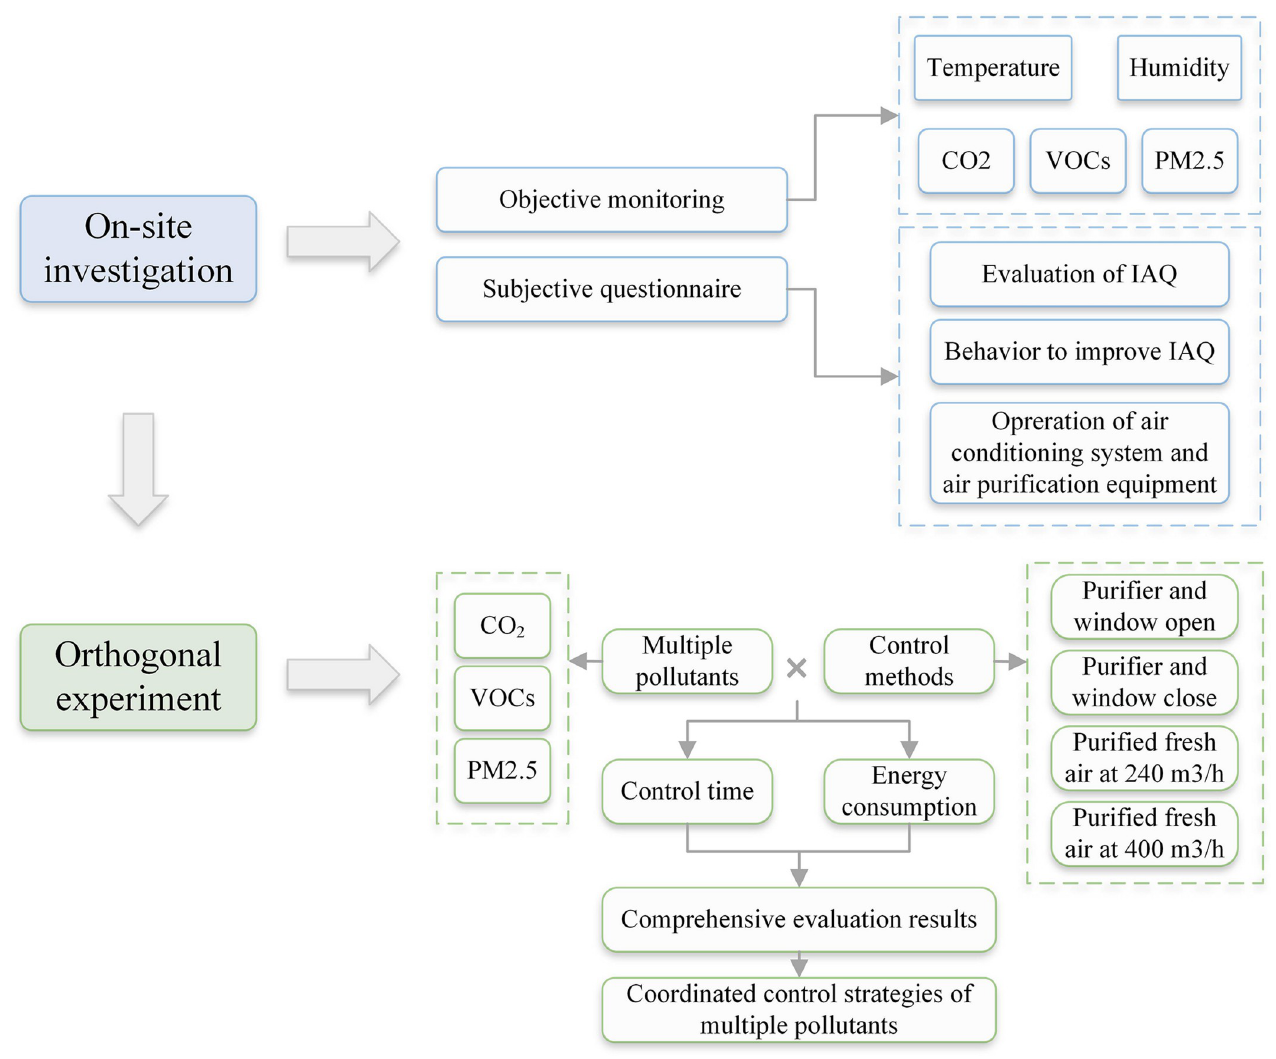
Fig 1. Flowchart of the methods